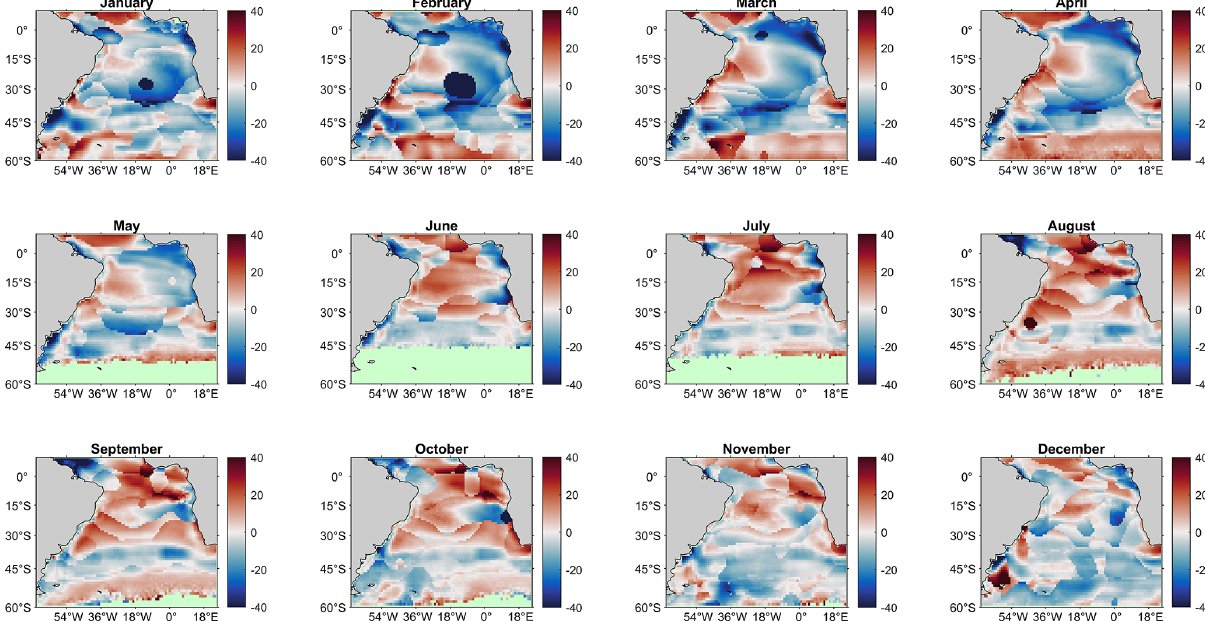
Figure B3. Monthly comparison between p CO 2 ( sw ) climatologies estimated by the SA-FNN NCP and W2020 (Watson et al., 2020a) clima- tology referenced to 2010 (SA-FNN NCP p CO 2 – W2020 p CO 2 ). Red (Blue) shades indicate regions where SA-FNN NCP is greater (less) than the W2020 climatology.